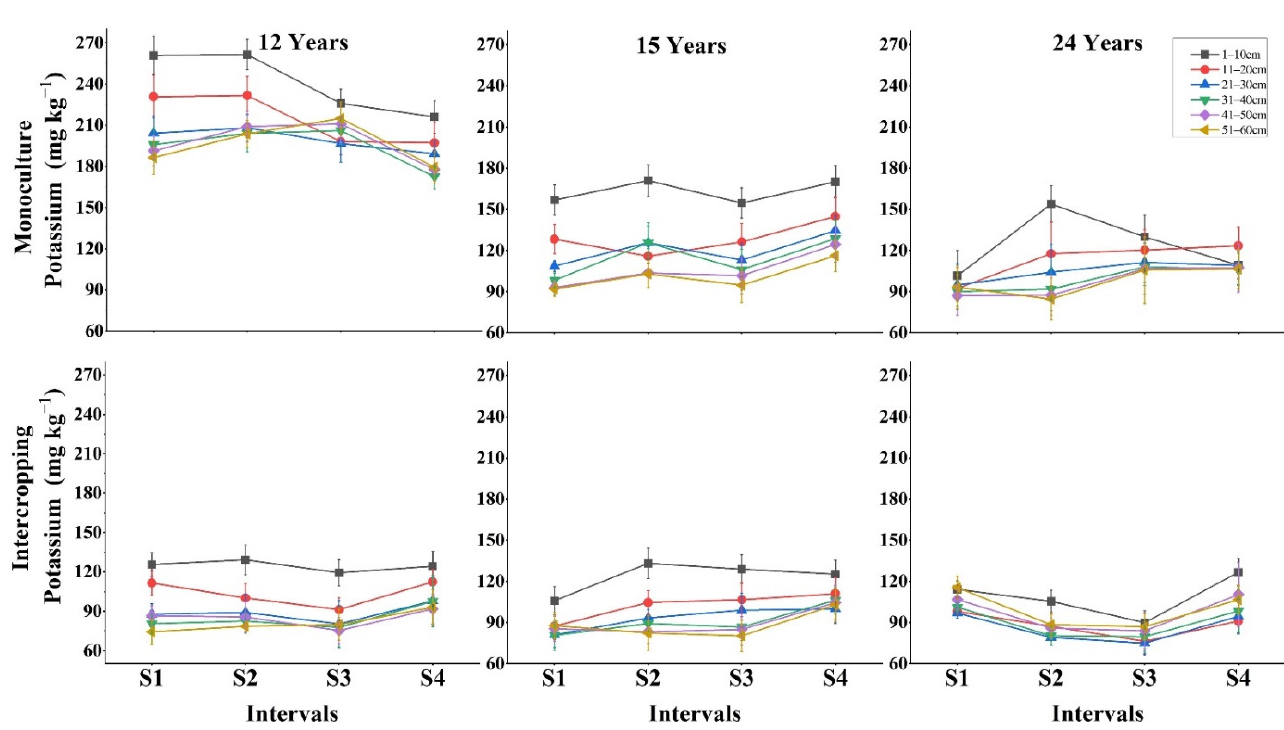
Figure 4. Soil available K in different soil layers across four sampling intervals (S1, June 2018; S2, September 2018; S3, December 2018; S4, March 2019) within different-aged stands of two plantation management types (rubber monoculture versus rubber–F. macrophylla intercropping).